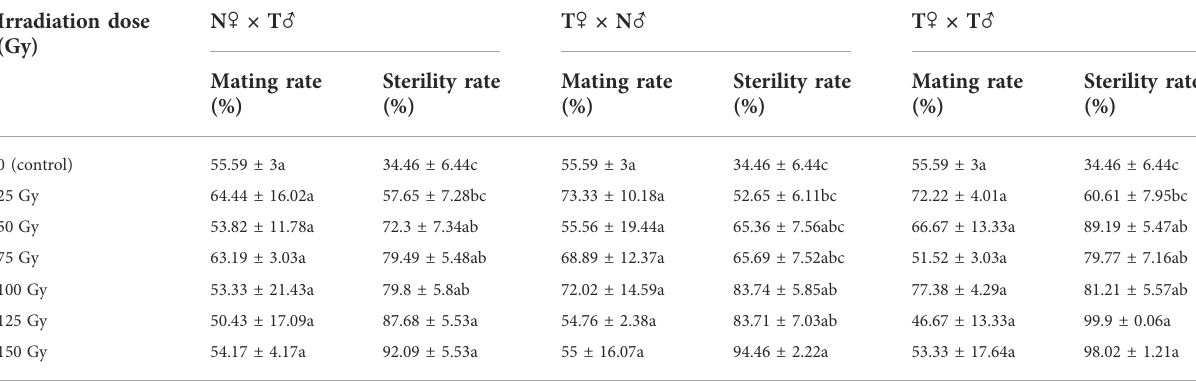
TABLE 4 Mean (±SE) mating rate and sterility rate for F 1 offspring adults of Spodoptera litura by different mating types: T \ × N _ , N \ × T _ , and T \ × T _ (N = normal individual whose parents were both unirradiated; T = F 1 individual whose male parent was irradiated with 250 Gy dose of X-ray). Irradiation dose N \ × T (Gy)